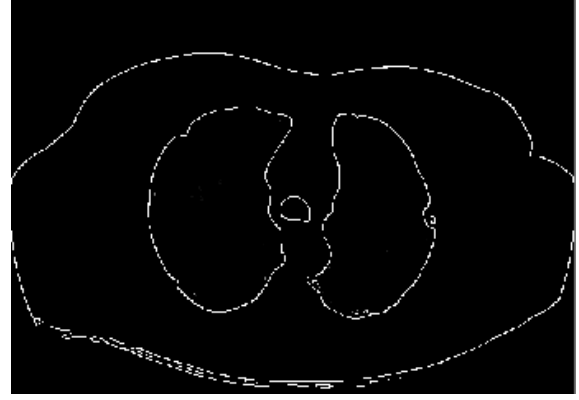
Figure 10. Edge detection using Canny.